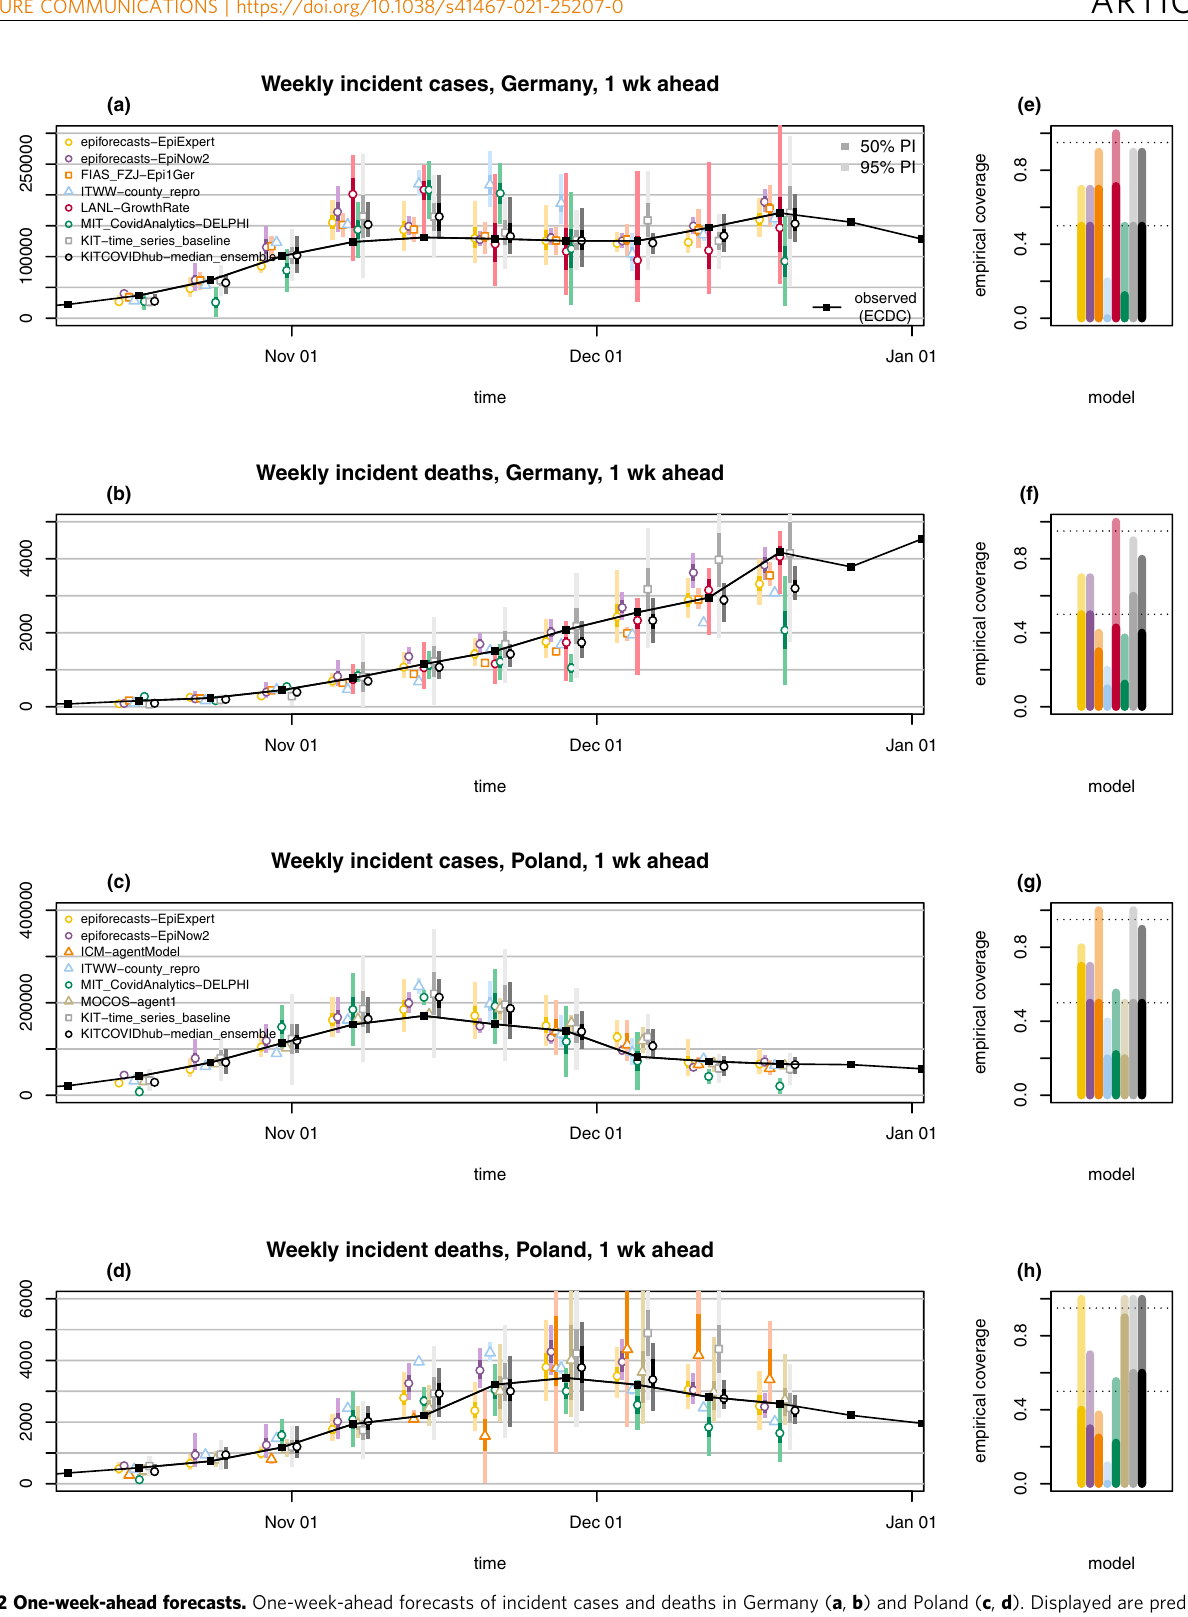
Fig. 2 One-week-ahead forecasts. One-week-ahead forecasts of incident cases and deaths in Germany ( a , b ) and Poland ( c , d ). Displayed are predictive medians, 50% and 95% prediction intervals (PIs). Coverage plots ( e – h ) show the empirical coverage of 95% (light) and 50% (dark) prediction